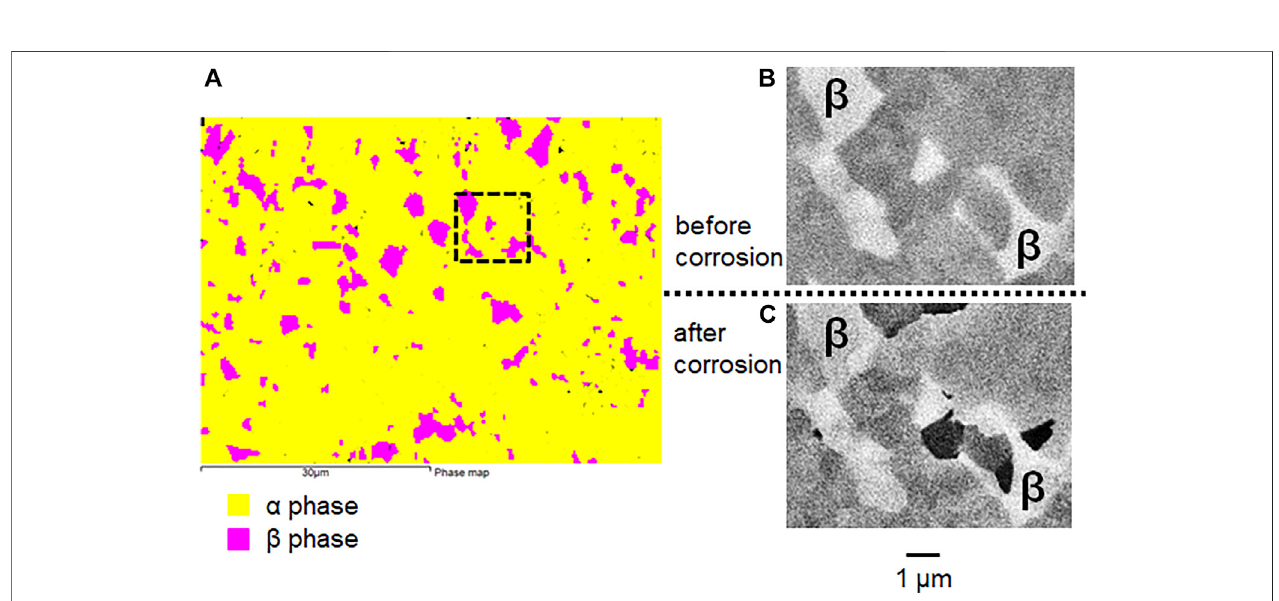
FIGURE 5 | (A) EBSD phase map (B) BSE image of mirror-polished Ti6Al4V before and (C) BSE image after potentiostatic test in 2 M HCl at − 510 mV vs. SCE for 30 min at 37 ° C.